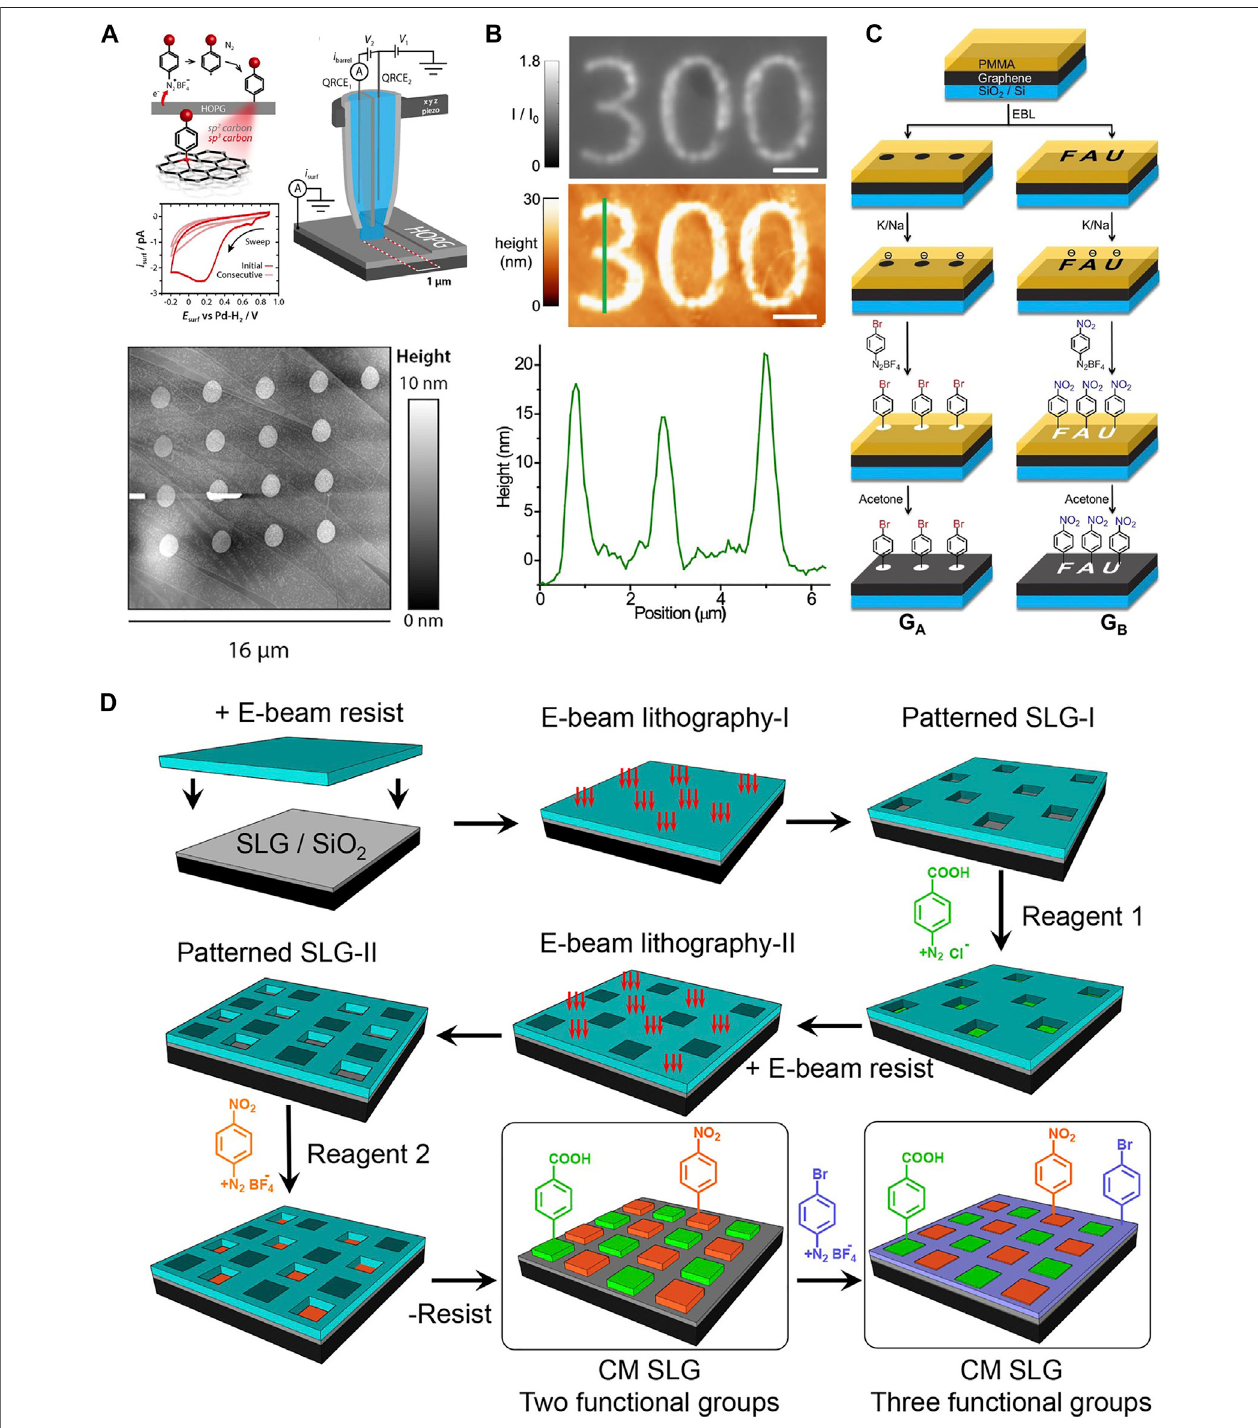
FIGURE 1 | Covalent patterning of graphene with a microscale patterning resolution. (A) Schematic representation of the local electrochemical reduction of diazonium modi fi cation at an HOPG electrode surface using a scanning electrochemical cell microscopy (SECCM) setup, resulting in the an sp 3 carbon in the HOPG surface layer and the corresponding AFM image of covalent patterning on the HOPG surface. Panel adapted with permission from Kirkman et al., (2013). Copyright: American Chemical Society. (B) The interference re fl ection microscopy, AFM images, and the corresponding line pro fi le of template-assisted laser writing for covalent patterning of graphene, achieving ~400 nm patterning resolution. Scale bar = 2 µm. Panel adapted with permission from Li et al., (2019). Copyright: American ChemicalSociety. (C) Schematicillustrationofthereactionmechanismforthetemplate-assistedcovalentpatterningmonolayergraphene via electron-beamlithography. Thediameterofadotis5 μ m,andthelengthandwidthoftheFAUlogoare20and30 μ m,respectively.PaneladaptedwithpermissionfromWeietal.,(2020).Copyright: JohnWileyandSons. (D) Schematicillustrationforthesequentialcovalentpatterningofgraphenewithmultiplediazoniumcomponentsusingthecombinedtechniqueof electron beam lithography and self-limiting diazonium chemistry. Panel adapted with permission from González et al., (2021). Copyright: American Chemical Society.